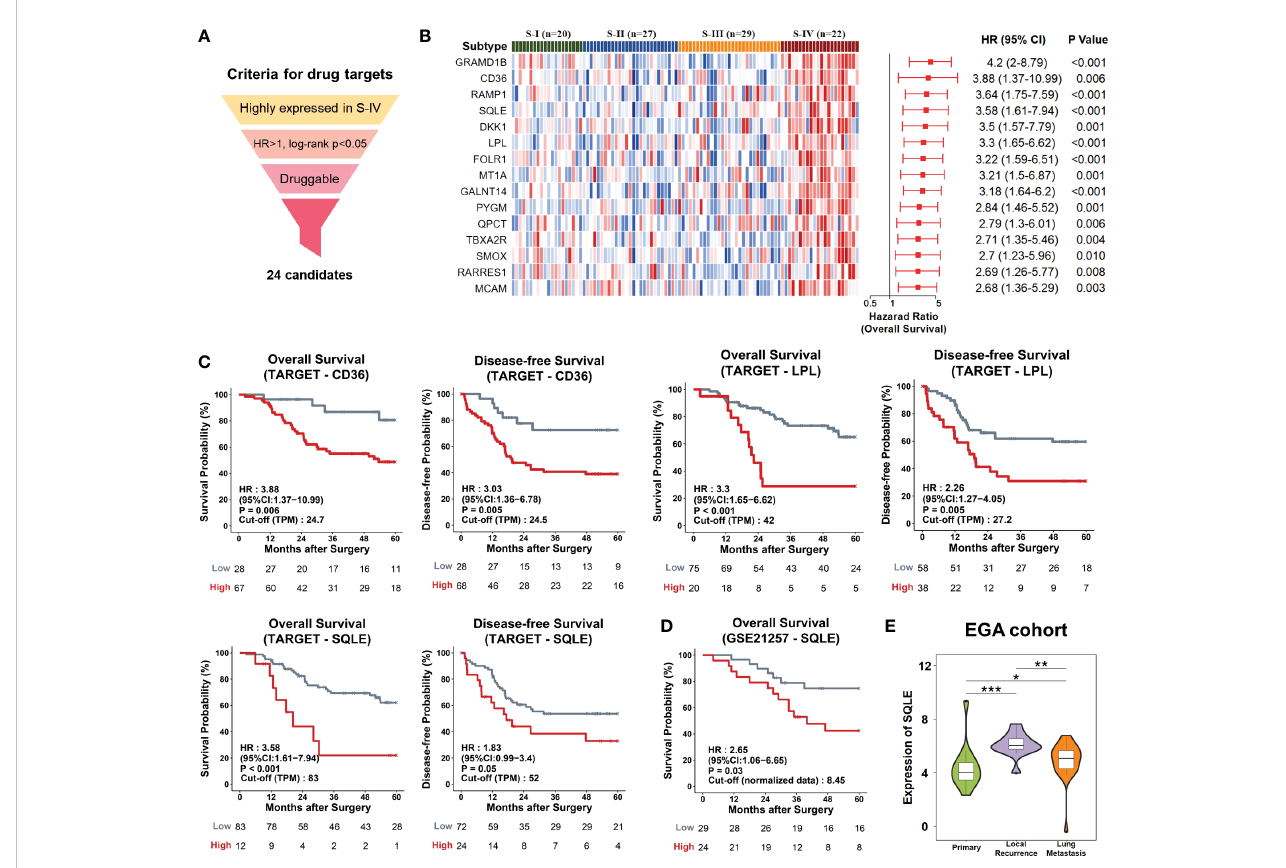
FIGURE 4 Potential drug targets for osteosarcoma patients. (A) The work fl ow of the drug-target screening pipeline. We set three layers of fi ltration and obtained 24 candidates. (B) The candidates were ranked by hazard ratio (HR), and the top 15 were chosen to be presented. Left, Heatmap depicted the relative abundances of the top 15 candidates. Right, Forrest plot showed risk scores of genes. The red points denoted the HR of overall survival. The endpoints indicated lower or upper of the 95% con fi dence intervals (CI). P-values were calculated by log-rank test. (C) Kaplan-Meier curves. The TARGET patients were divided into high/low gene expression groups using the optimal cut-off value. Patients with high expression levels of CD36, LPL, or SQLE displayed poor outcomes. (D) The GSE21257 patients with high expression levels of SQLE displayed poor outcomes. (E) Violin plots showed the distributions of expression levels of SQLE in the EGA samples with different pathological stages. The width represented the number of samples at the given expression level on the height. *P<0.05, **P<0.01, ***P<0.001 by